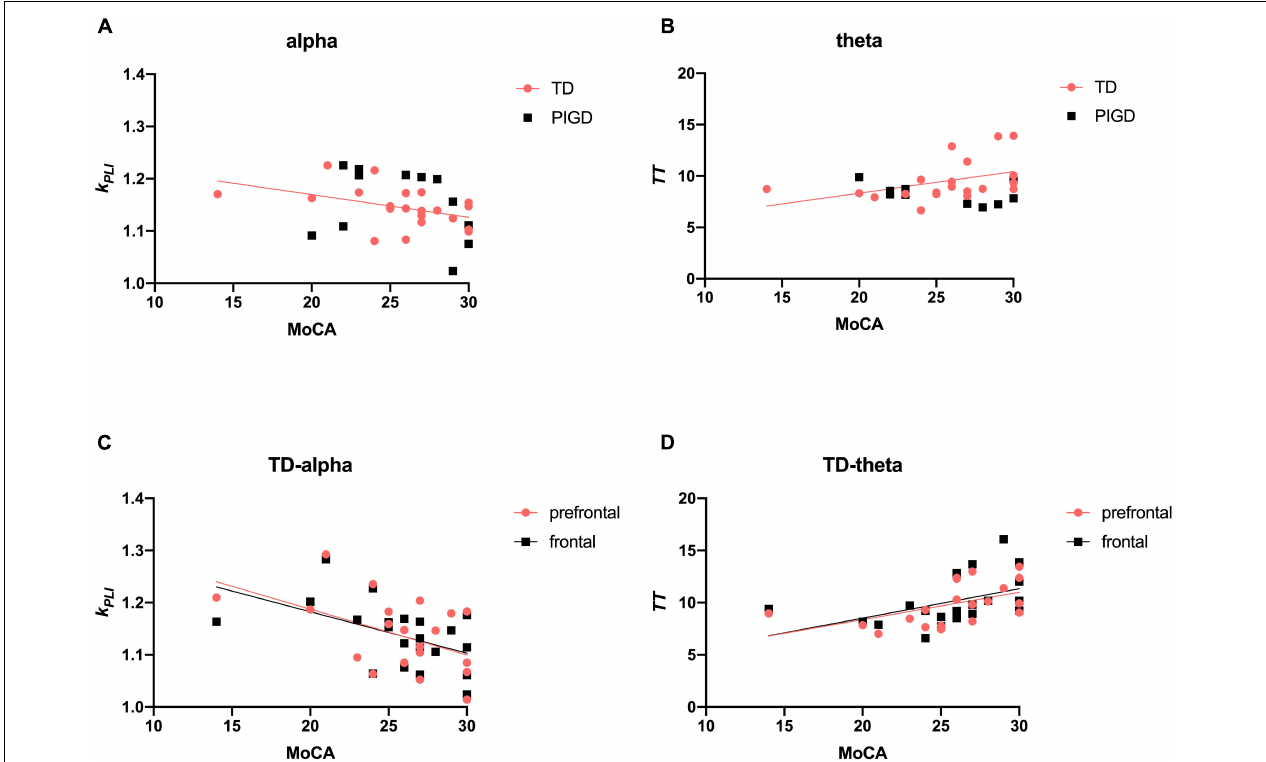
FIGURE 3 | Scatter plot illustrating the correlation between EEG signature and cognition in patients with PD. Upper row: correlations of EEG frequency bands with cognitive data (A,B) . Lower row: correlations of EEG characteristic brain regions with cognitive data (C,D) . A significant correlation ( p < 0.05) is marked in solid red and black lines.